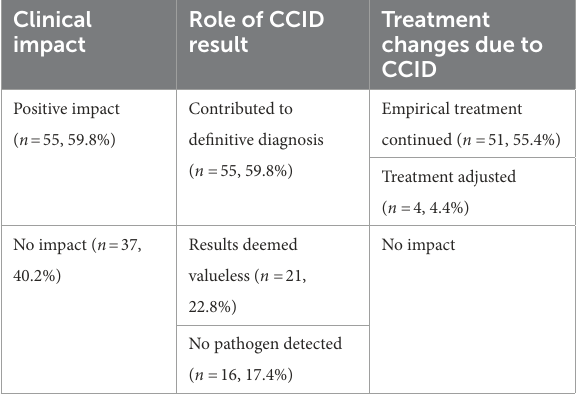
TABLE 3 Clinical impact and role of CCID